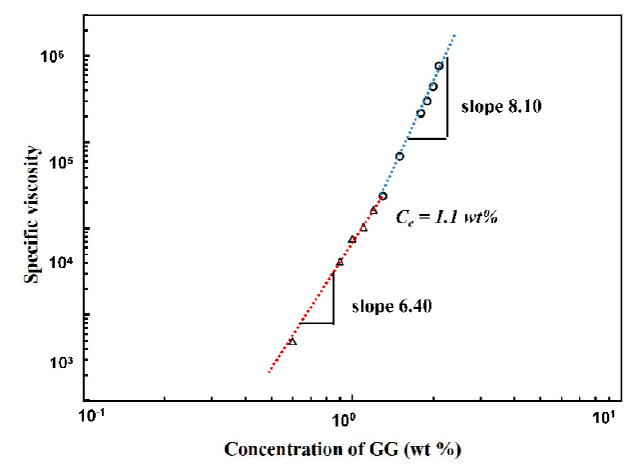
Figure 2. Plot of specific viscosity versus aqueous GG concentration.